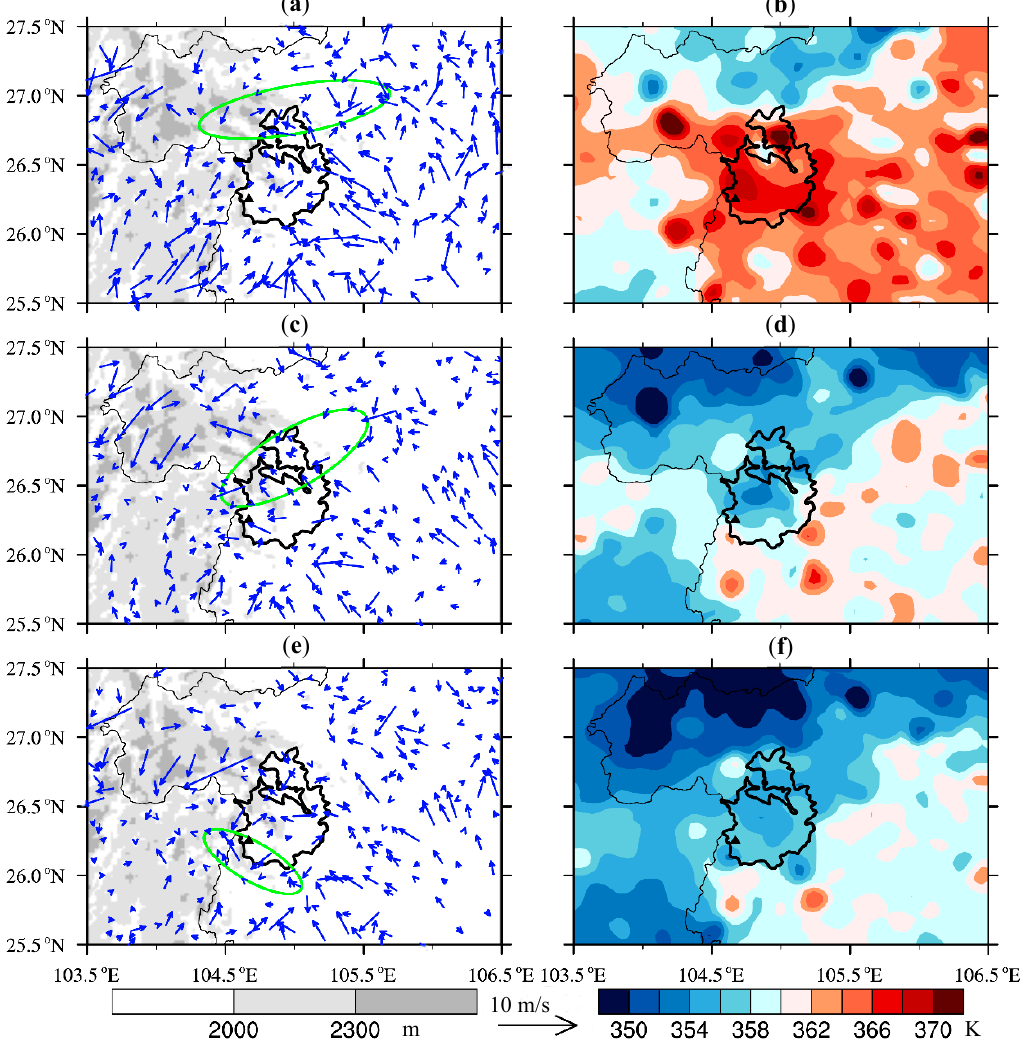
Figure 8. Distributions of the surface winds (blue vectors, units: m / s) and θ e (shaded, unit: K, right) observed by automatic weather stations (AWSs) at ( a , b ) 09:00 UTC; ( c , d ) 12:00 UTC; ( e , f ) 13:40 UTC on 22 July 2019. The green circles denote the convergence regions, and shaded areas in the left panel denote the terrain height (units: